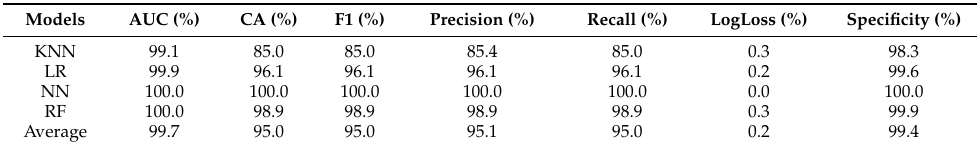
Figure 9. A cluster of data fusion output showing thermal blobs from two participants in a cluster with timestamps. Table 1. Evaluation results from data mining models for parameters such as AUC, CA, FI, Precision, The black arrow on ‘C_ID_080519_11.58\thermal_212.png’ points to the location of the lateral sensor, the red Recall, LogLoss, and Specificity. arrow points to the participant, and the white arrow points to the heat spot from tea/coffee cups.